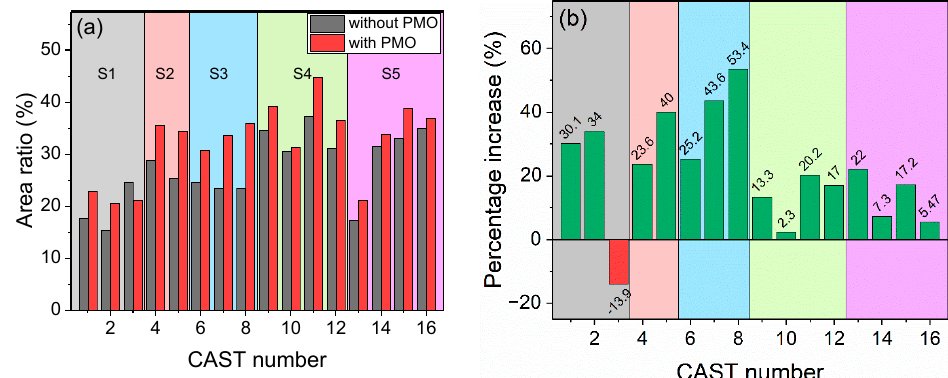
Figure 6. ( a ) The area ratio of the equiaxed grain zone of the experimental billets and ( b ) the percentage increase in equiaxed grain area of billet with PMO treatment.